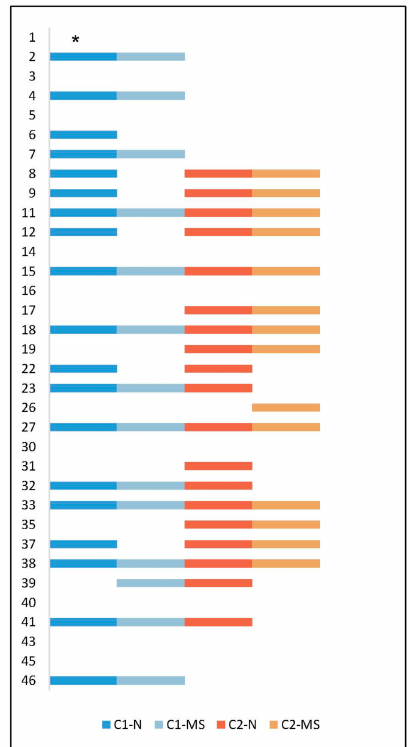
Figure 1. Presence of Staphylococcus aureus in the nares and maxillary sinus in 34 patients at initial collection (C1) and at follow-up (C2) after approximately 11 years. The Y-axis shows the study ID for all 34 patients. One step on the X-axis symbolizes S. aureus isolated at a specific time point and site. Sample sites: maxillary sinus (MS), nares (N). * One sample from nares at C1 was not available. The investigated S. aureus isolates were almost fully susceptible to all tested antibiotics. Four isolates from four different patients displayed resistance. One nasal S. aureus